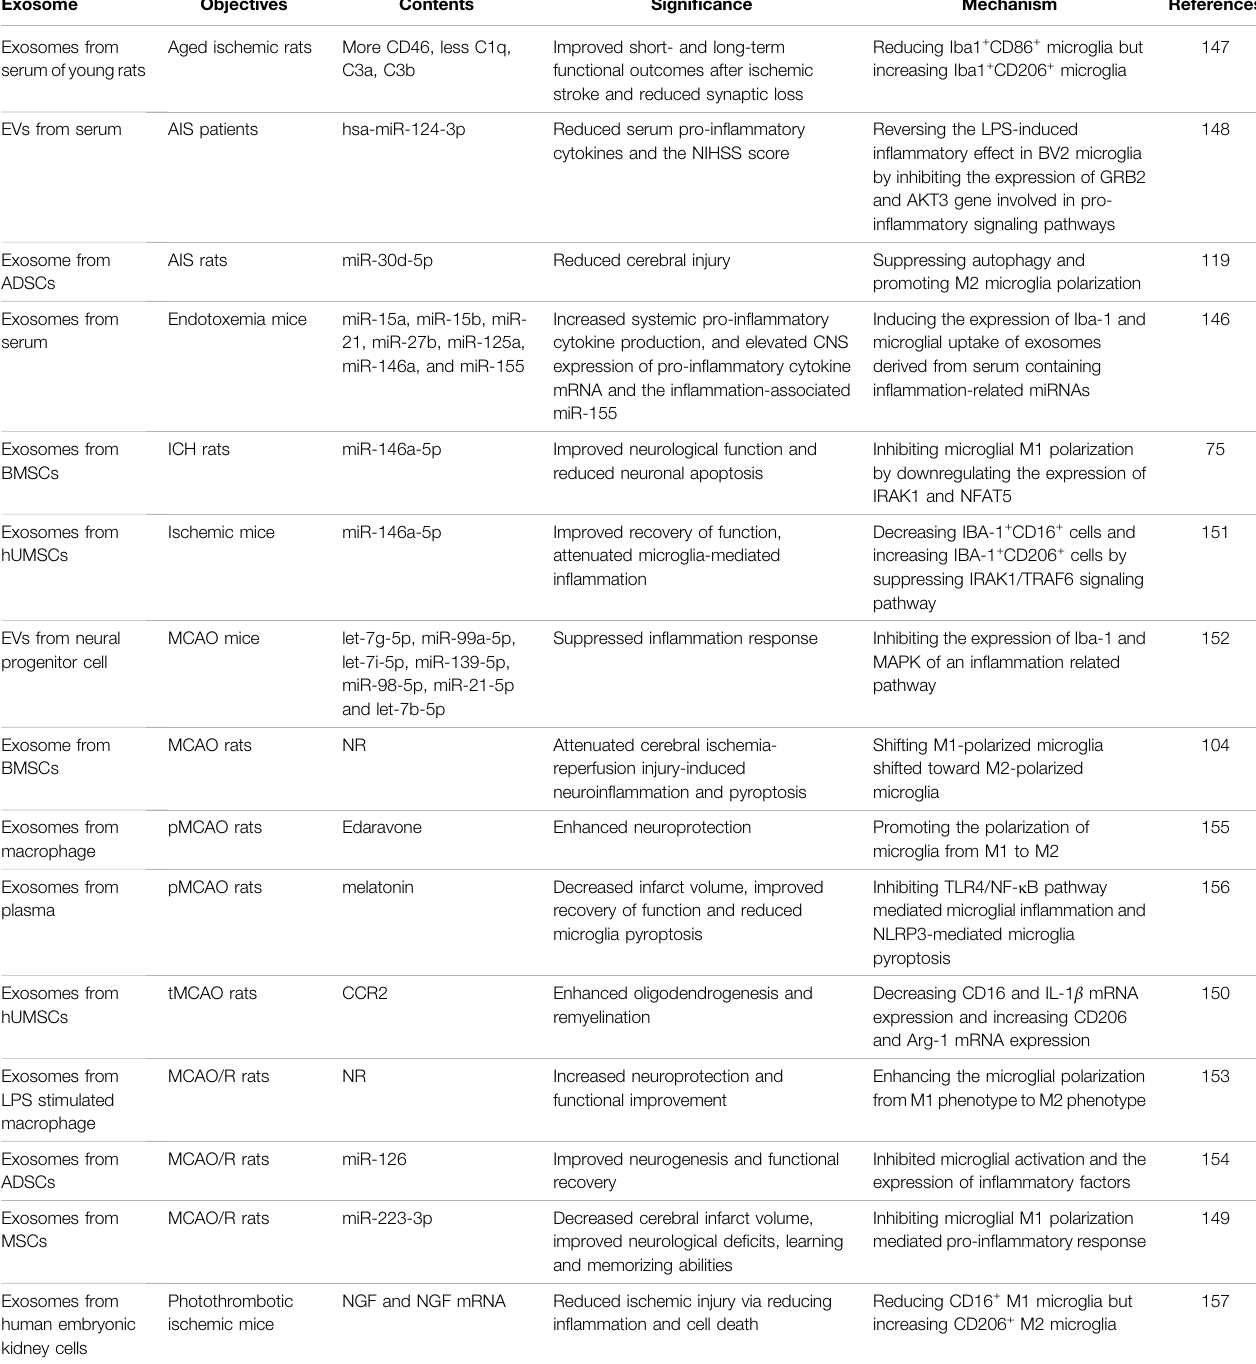
TABLE 1 | Therapeutic effects of exosome on stroke by targeting microglia